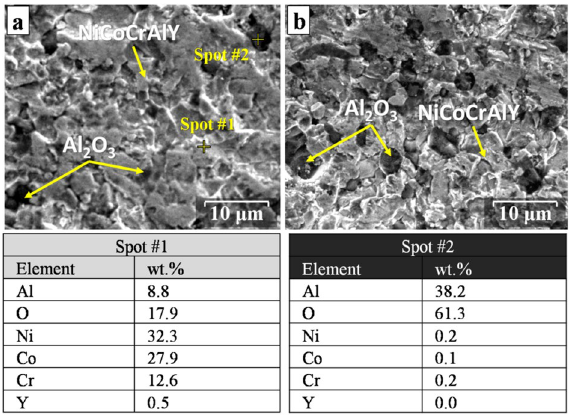
Figure 13. Secondary electron images of the surface of ( a ) as-received and ( b ) nanocrystalline MCrAlY coatings at the early stage of the isothermal oxidation process (5 h) at 1000 °C. EDX results from indicated points are also provided at the bottom of the